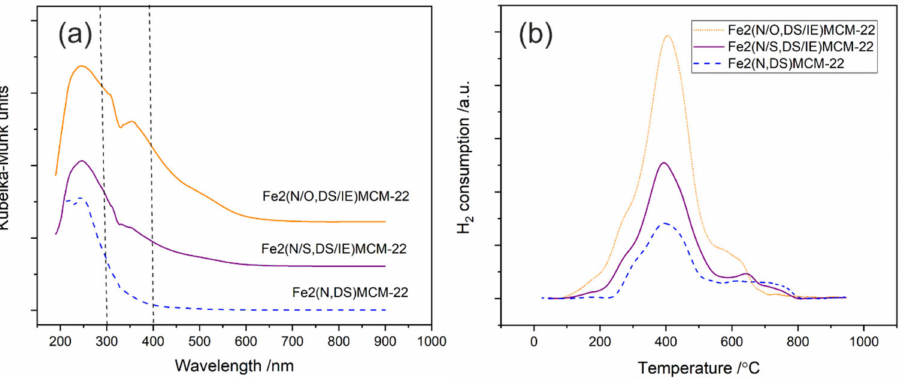
Figure 8. ( a ) UV–vis-DR spectra and ( b ) H 2 -TPR profiles of the samples Fe2(N,DS)MCM-22,